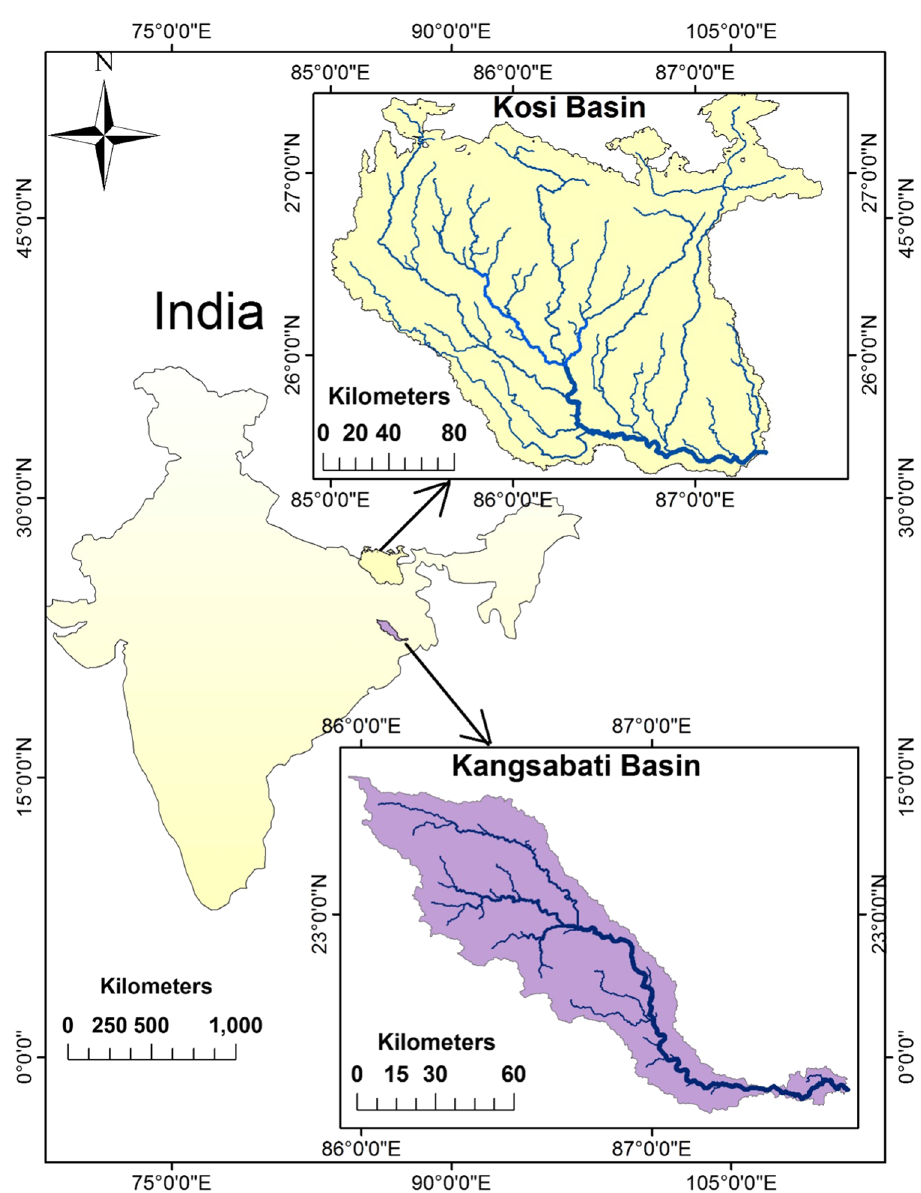
Fig. 1 The location map of Kosi and Kangsabati River